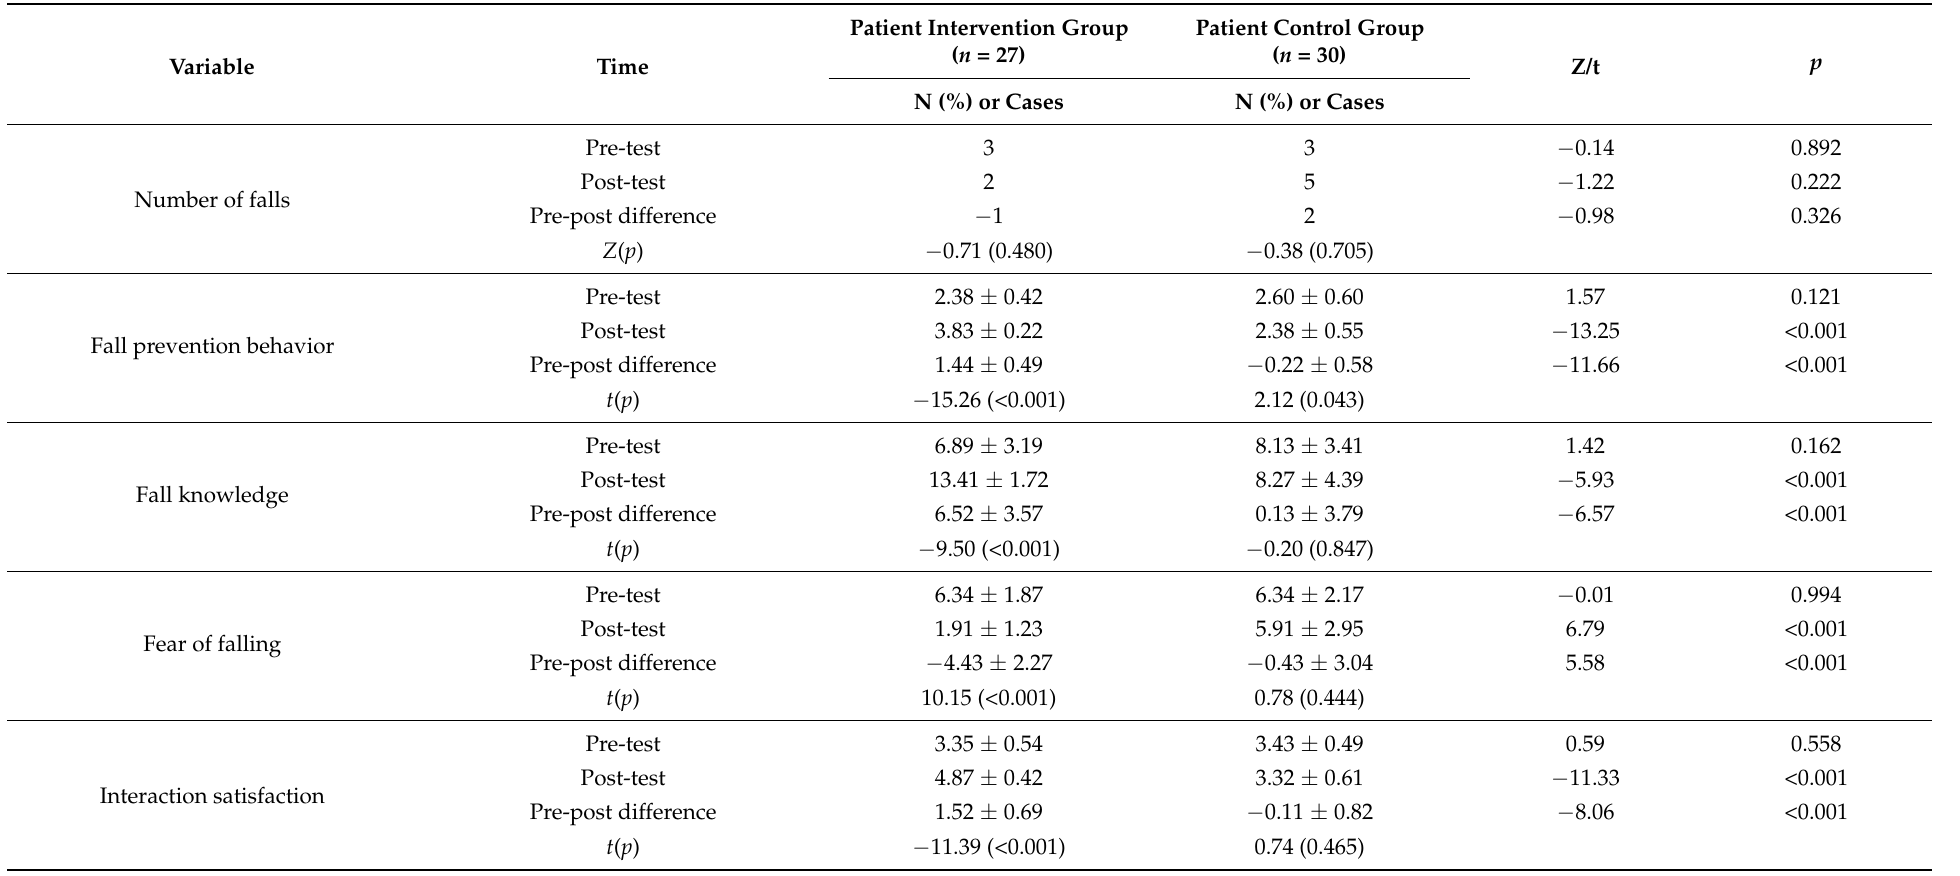
Table 3. Pre–post-difference test of the main study variables between patients and nurses in the control and intervention